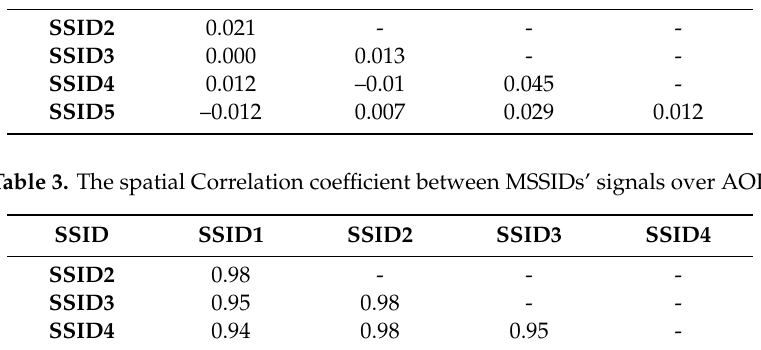
Table 2. The time correlation coefficient between MSSIDs’ signals at a certain point.